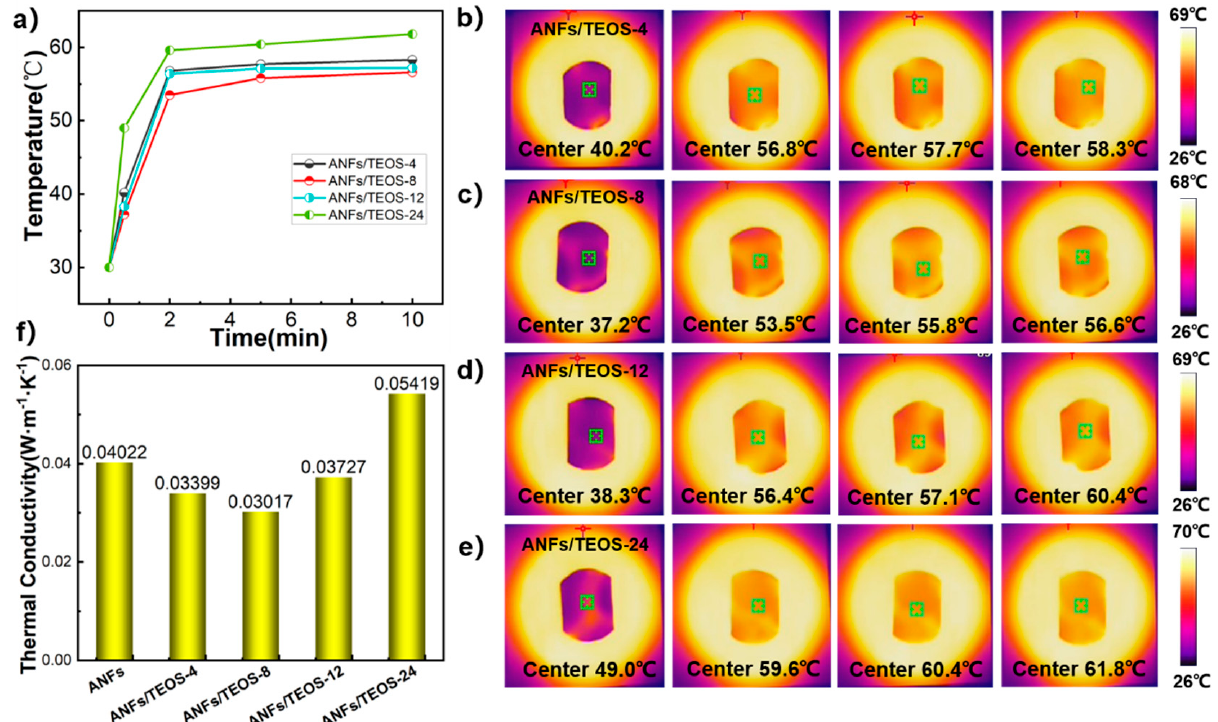
Figure 6. Thermal conductivity of the aerogels. ( a ) Curves of temperature change of one side of the samples with heating time of the other side. ( b – e ) Infrared thermal images of different aerogels. ( f ) Thermal conductivity of different aerogels.